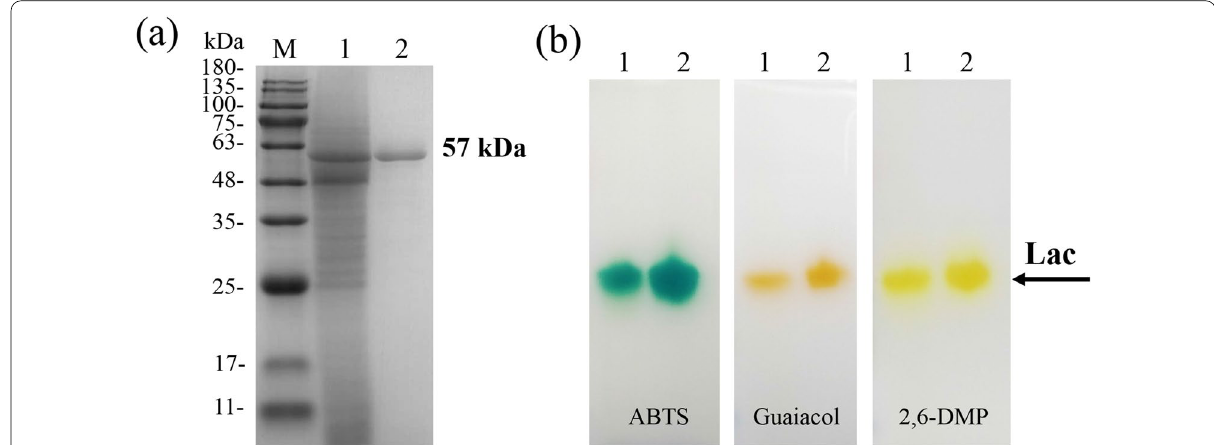
Fig. 2 SDS-PAGE ( a ) and native-PAGE ( b )electrophoretograms of the laccase from C. gallica (lane M: molecularmass of marker; lane 1: the crude laccase; lane 2: the purified laccase; kDa,the unit of protein molecular mass; ABTS, guaiacol, and 2,6-DMP were used assubstrates)